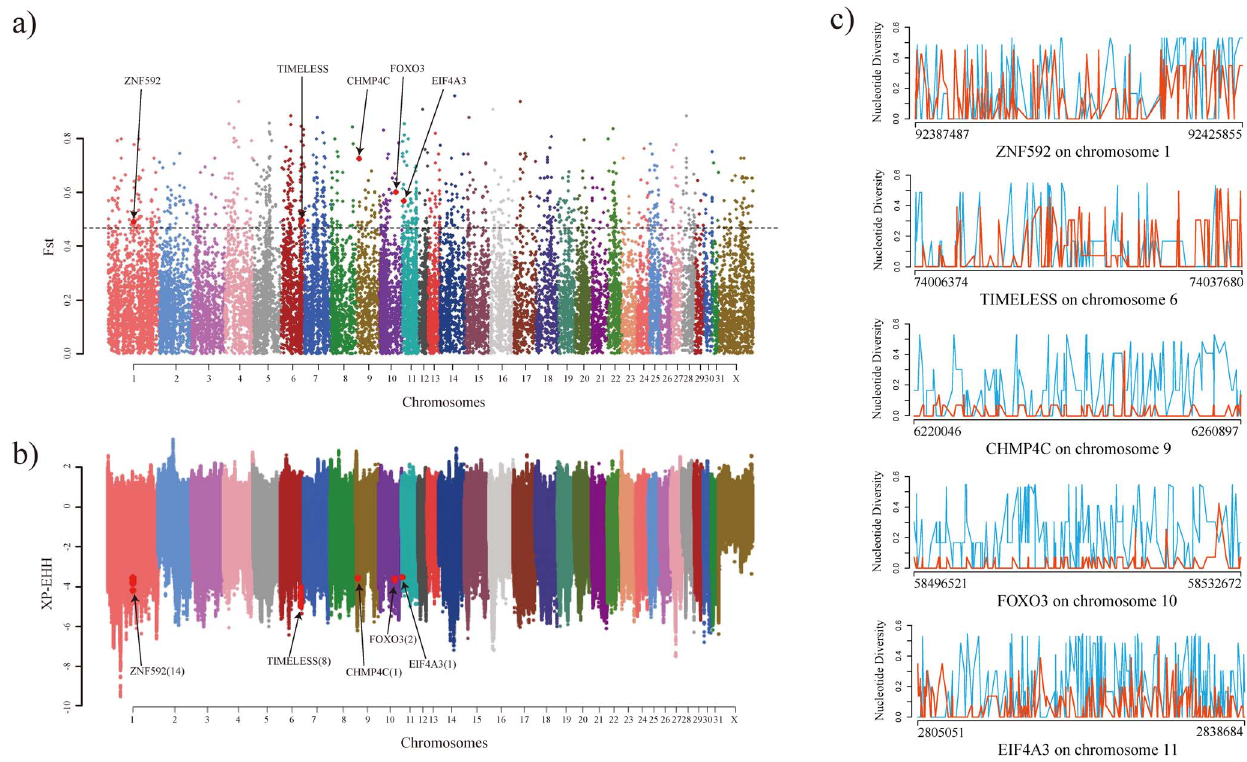
Figure 3. Signatures of correlation between DEGs from Thoroughbred RNA-seq and selected genes associated with nucleotide diversity, F ST and XP-EHH from Thoroughbred and Jeju pony DNA sequence. a) Manhattan plot of F ST (Dotted line=cut-off value of the top 5% with empirical p-values of , 0.05. Red point=common genes between the DEGs, Thoroughbred selected genes associated with F ST and XP- EHH). b) Manhattan plot of XP-EHH value (Red point=Common genes between the DEGs and Thoroughbred selected genes associated with F ST and XP-EHH). c) Nucleotide diversity line plot of five common genes (sky blue color line=Jeju pony, orange color